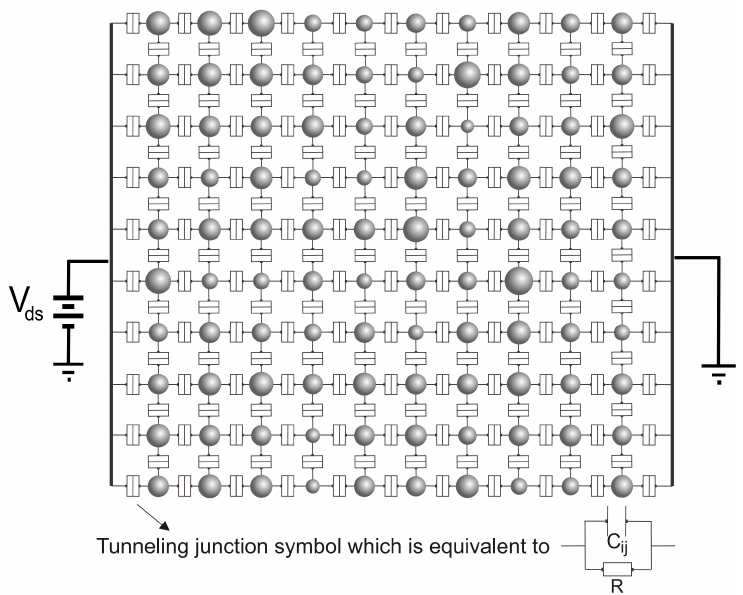
Figure 2. Equivalent circuit of 2D arrays of palladium nano-islands.